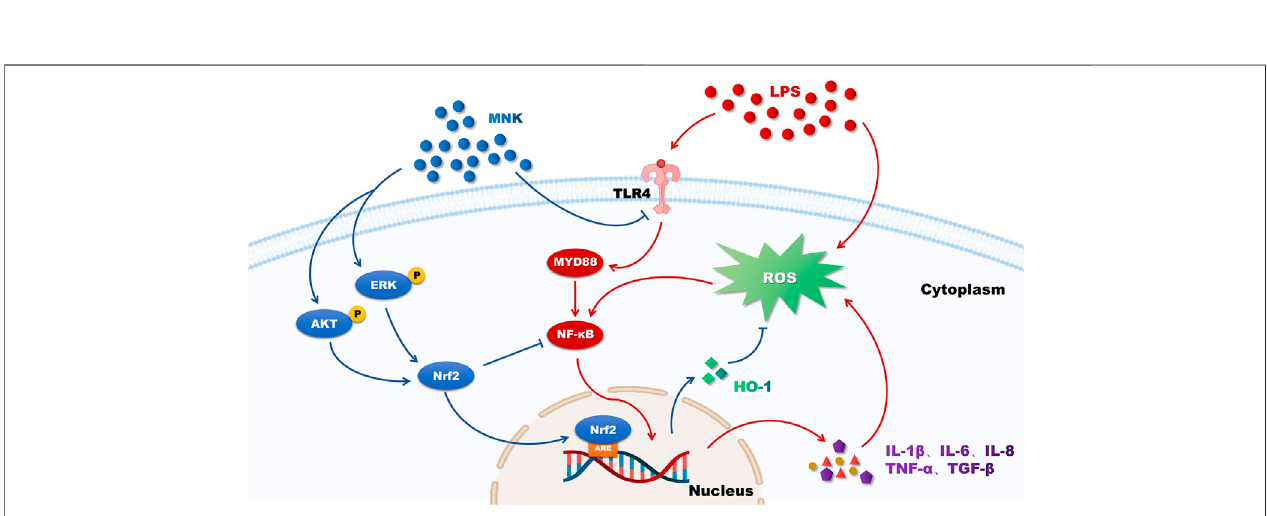
FIGURE 8 | The putative mechanism of 2-methyl nonyl ketone (MNK) attenuating the in fl ammatory response and oxidative stress of MAC-T cells induced by lipopolysaccharide (LPS). Red arrows indicate the effects of LPS on MAC-T cells and blue arrows indicate the protective effects of MNK.